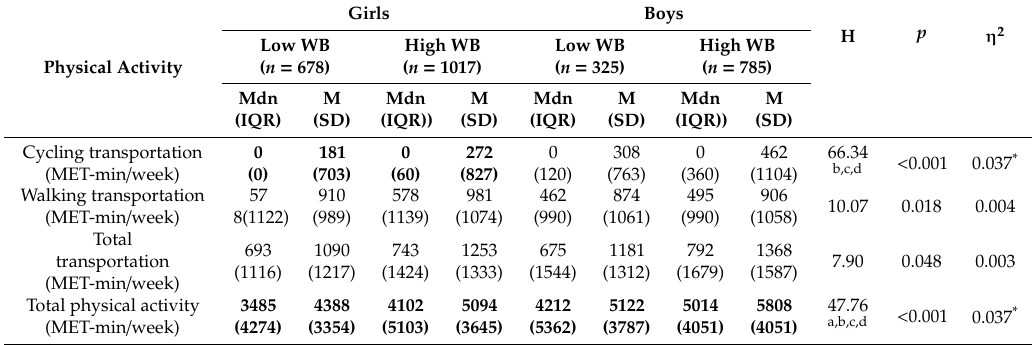
Table 2. Weekly transportation and overall physical activity in girls and boys by their well-being (WB) level.